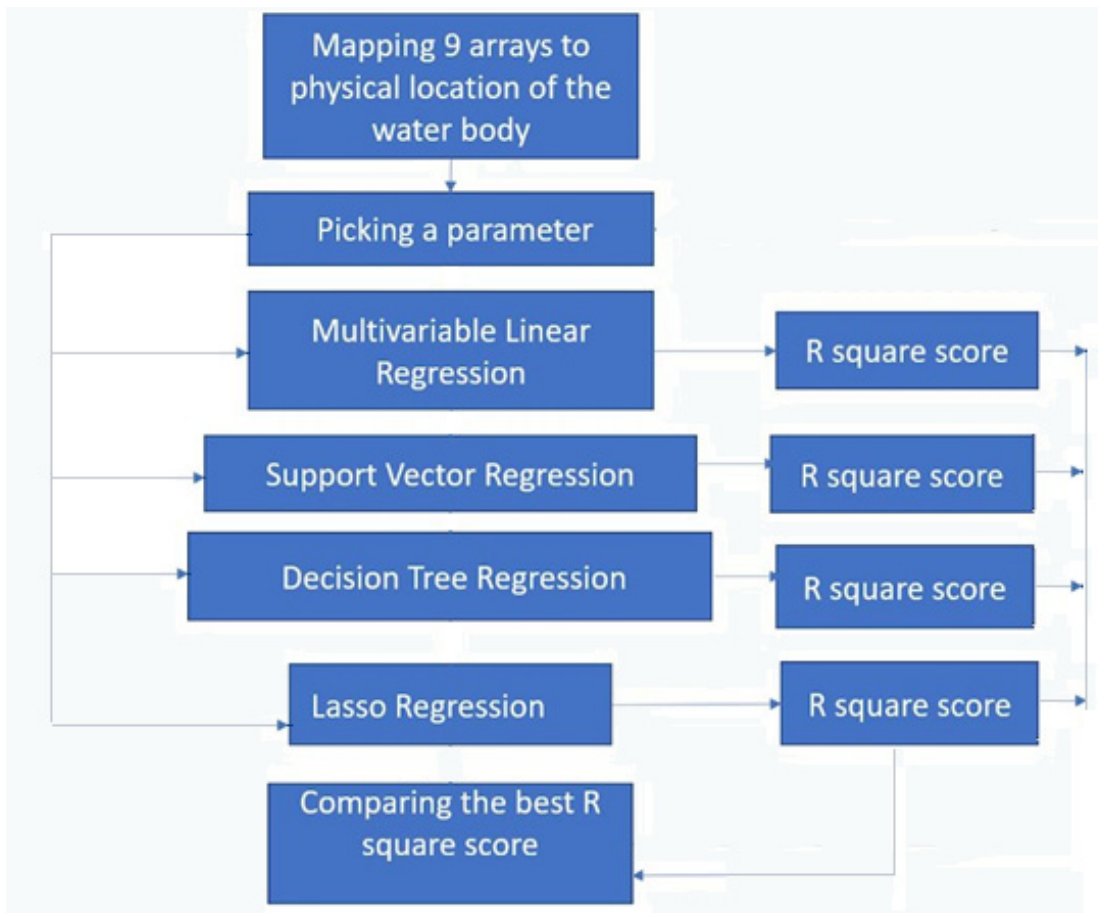
Figure 3. Methodology used.